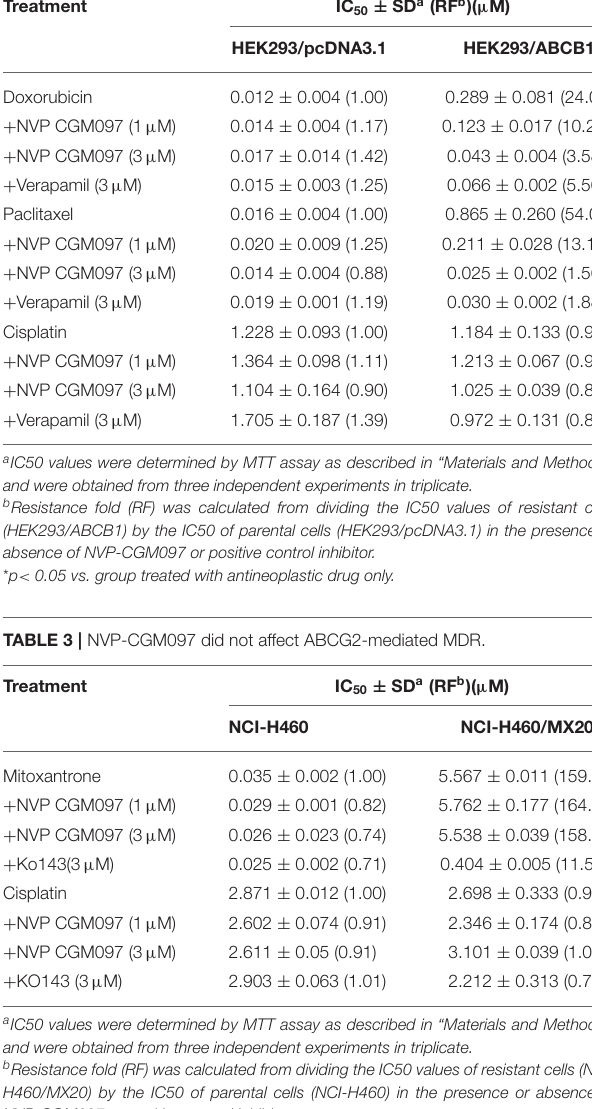
TABLE 2 | NVP-CGM097 sensitized ABCB1-gene-transfected cells to ABCB1 substrates. Treatment